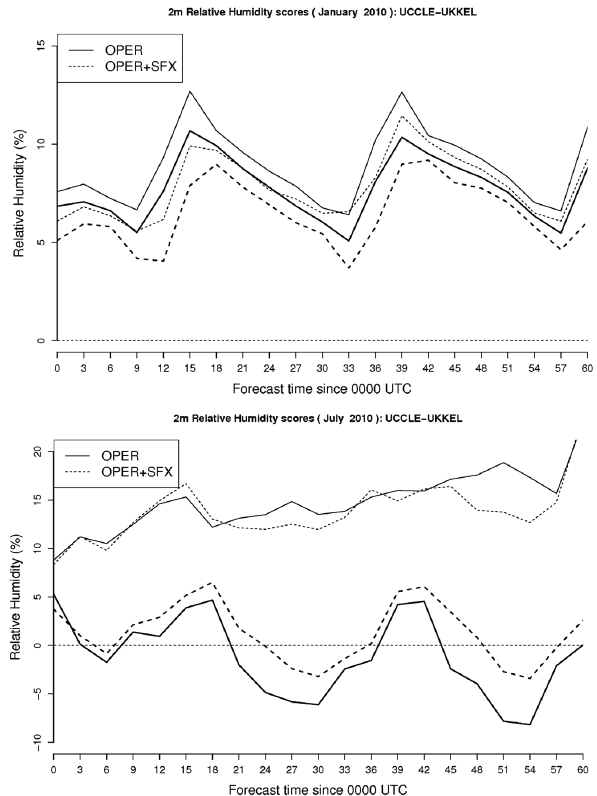
Fig. 5. Statistical scores of 2m relative humidity against observa- tions at the suburban Uccle station (bias: thick line; rmse: thin lines) for January (top) and July (bottom) for ALARO without SURFEX (OPER, solid lines) and with SURFEX (OPER+SFX, dashed lines)